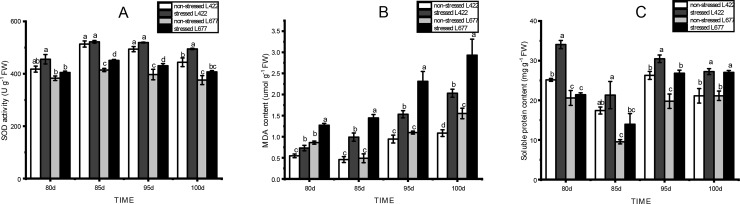
The changes of SOD (A), MDA (B), and Soluble protein content (C) in leaves of drought-tolerant and drought-sensitive varieties under drought stress. Values are mean ± standard error (n = 3). Different letters (a, b, c and d) above line graphs refer to significant difference among treatments (p<0.05).